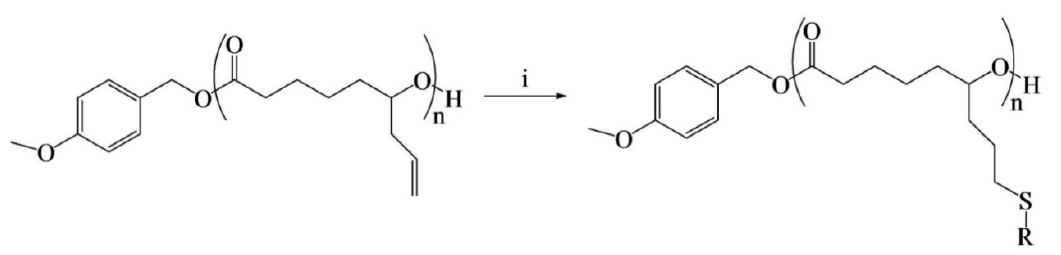
Figure 13. Synthesis of thiol-functionalized poly( ε -allyl- ε -caprolactone). Conditions: (i) IRGACURE 819, alkyl-thiol, chlo- roform, UV light (315–400 nm), RT as designed by Clamor et al.